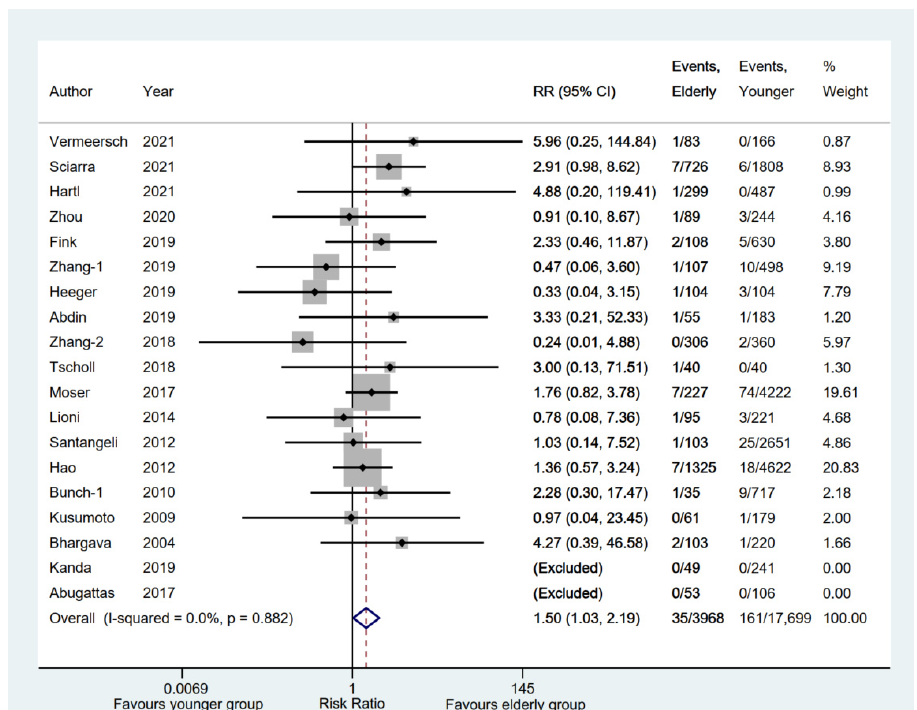
Figure 7. Forest plot comparing cerebrovascular events between elderly and younger groups [6,11–29,31]. The dotted red line represents the pooled risk ratio for cerebrovascular events between elderly and younger groups.